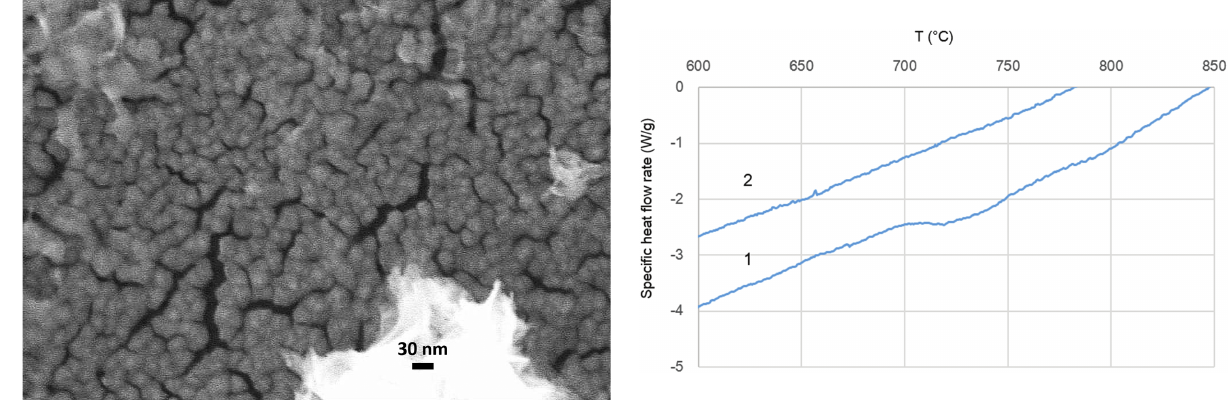
Figure 5: DTA curves for hydroxyapatite obtained by sol-gel method (1) and solid-state reaction